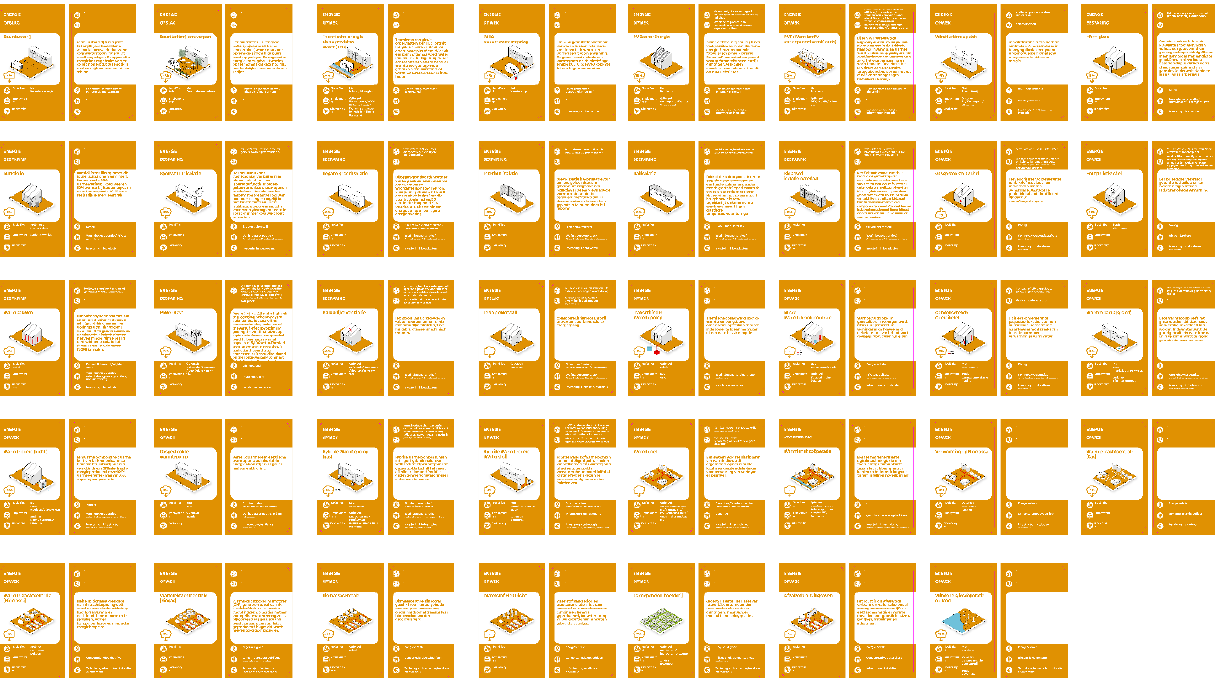
Figure 5. Visualized strategy cards based on the datasheets. Sample category: